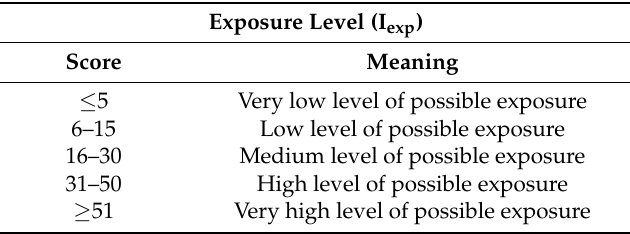
Table 8. Levels of possible exposure.